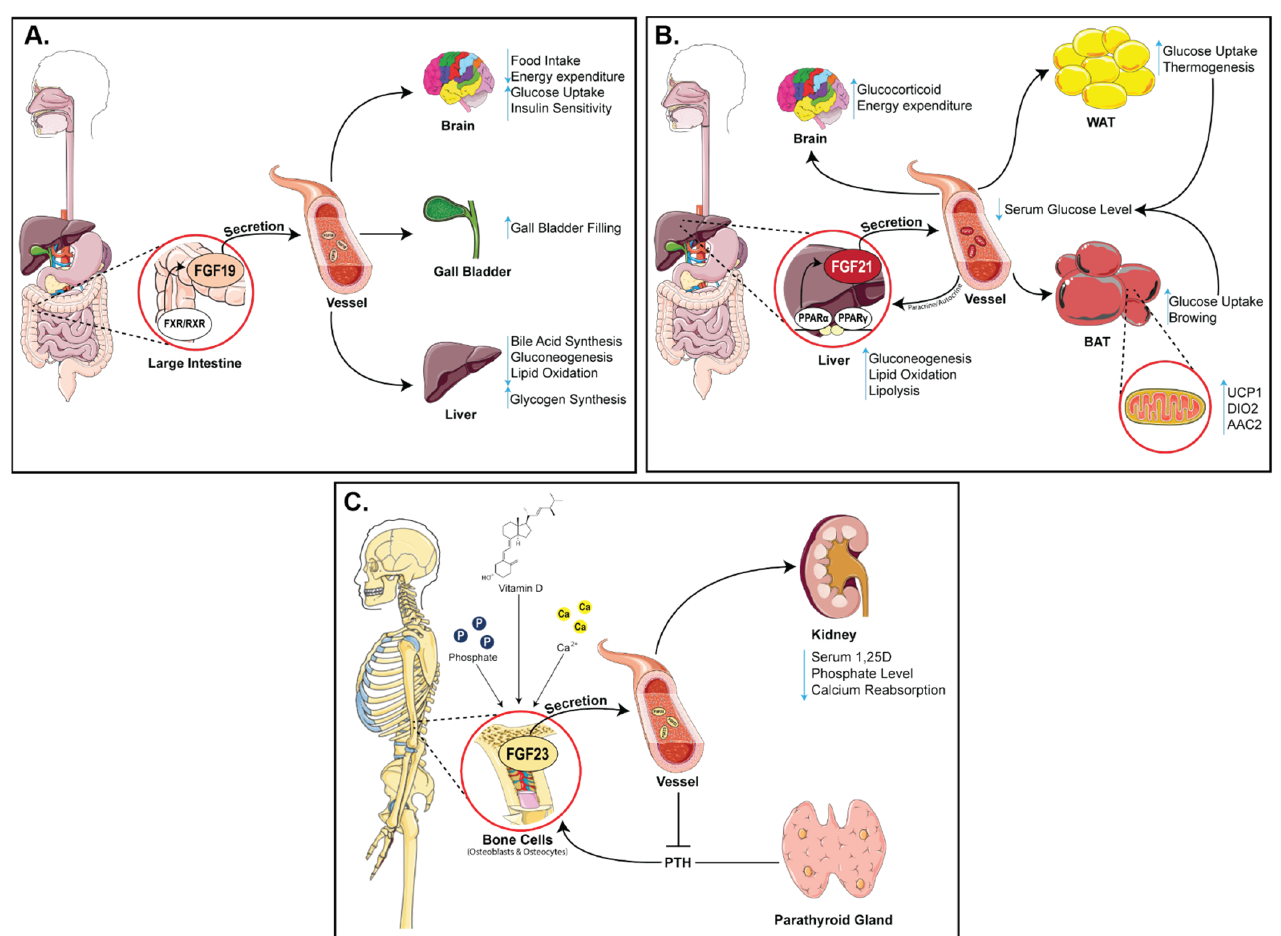
Figure 2. Physiological Activities of Endocrine FGFs. Panel- A : FGF19 is excreted from the large intestines and acts upon different organs such as the brain, gall bladder, and liver to perform important functions such as regulation of bile acid biosynthesis and gall bladder filling. In the liver, FGF19 suppresses the synthesis of bile acid and decreases gluconeogenesis and lipid oxidation, whereas it increases glycogen synthesis. In the brain, FGF19 inhibits food intake, decreases energy expenditure, and increases glucose tolerance. Panel- B : FGF21 is expressed in the liver and acts upon the brain, white adipose tissues, and brown adipose tissues to regulate glucose uptake. FGF21 also acts in a paracrine/autocrine manner to regulate gluconeogenesis and lipid oxidation. It stimulates the expression of mitochondrial UCP1 in white adipose tissue (WAT) and increases glucose uptake in brown adipose tissue (BAT). Panel- C : FGF23 is expressed in the bone marrow and mainly acts upon the kidney to regulate phosphate and calcium levels. FGf23 is also involved in regulation of PTH levels, lowering the levels of serum phosphate and 1,25 dihydroxyvitamin D.